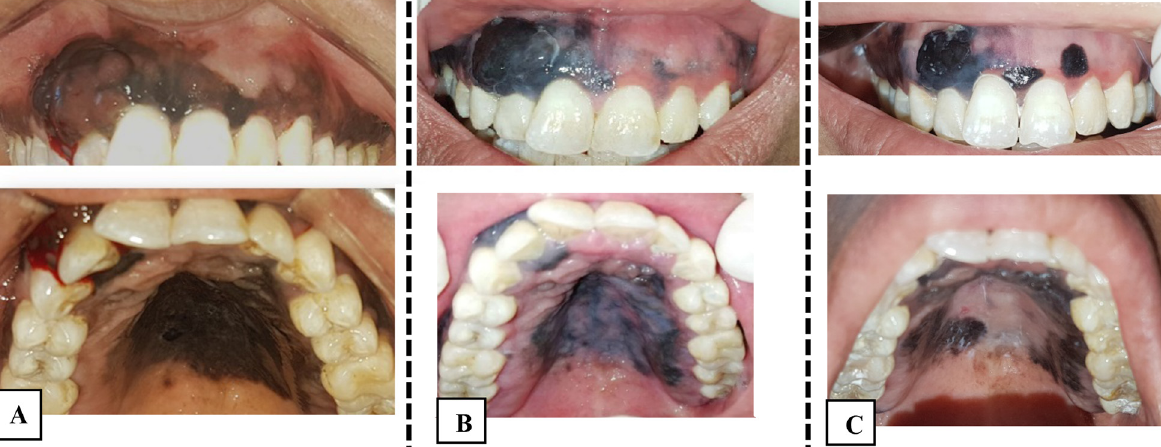
Fig. 4. Superposition of clinical aspects: A. Clinical presentation at diagnosis. B. 7-months follow up presentation. C. 10-months follow up presentation: decrease in the extent of the lesion.